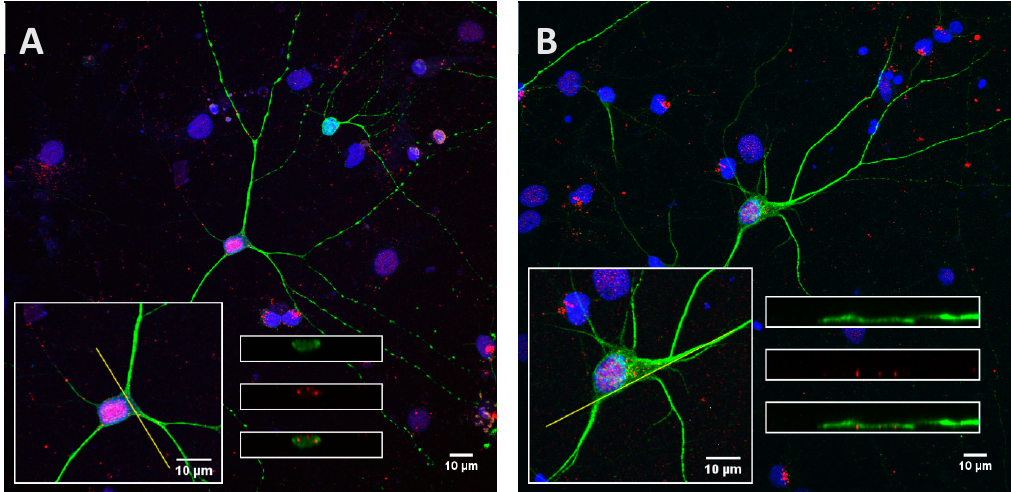
Figure A4. Orthogonal projections showing cross sections of the stacks along the yellow line. Cortical cells were incubated for 8 h with the Tau protein (15 μ g; A ) and its highly phosphorylated form (1.5 μ g; B ).